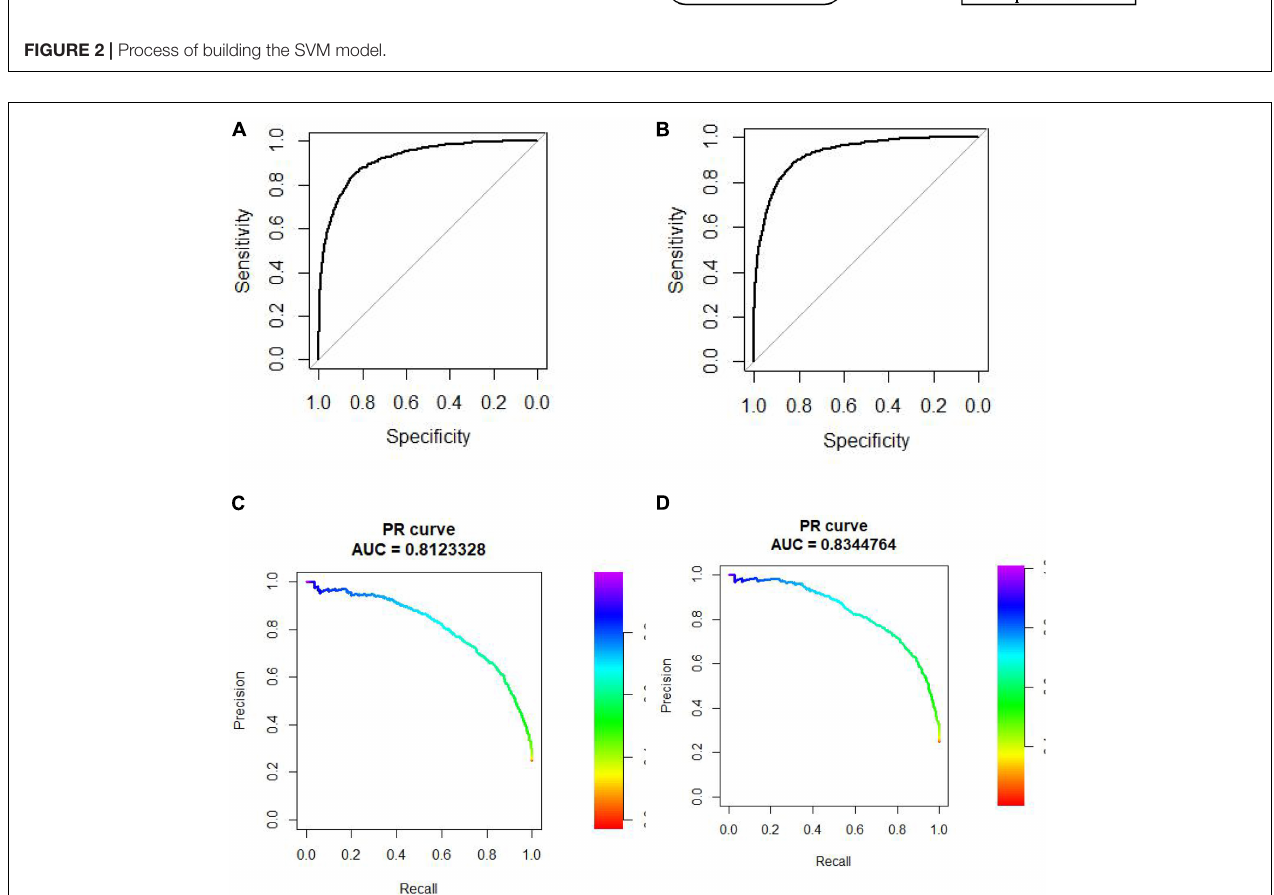
FIGURE 3 | (A) ROC curve of “SP.” Experiment. (B) ROC curve of “SM” experiment. (C) PR curve of “SP” experiment. (D) PR curve of “SM” experiment.